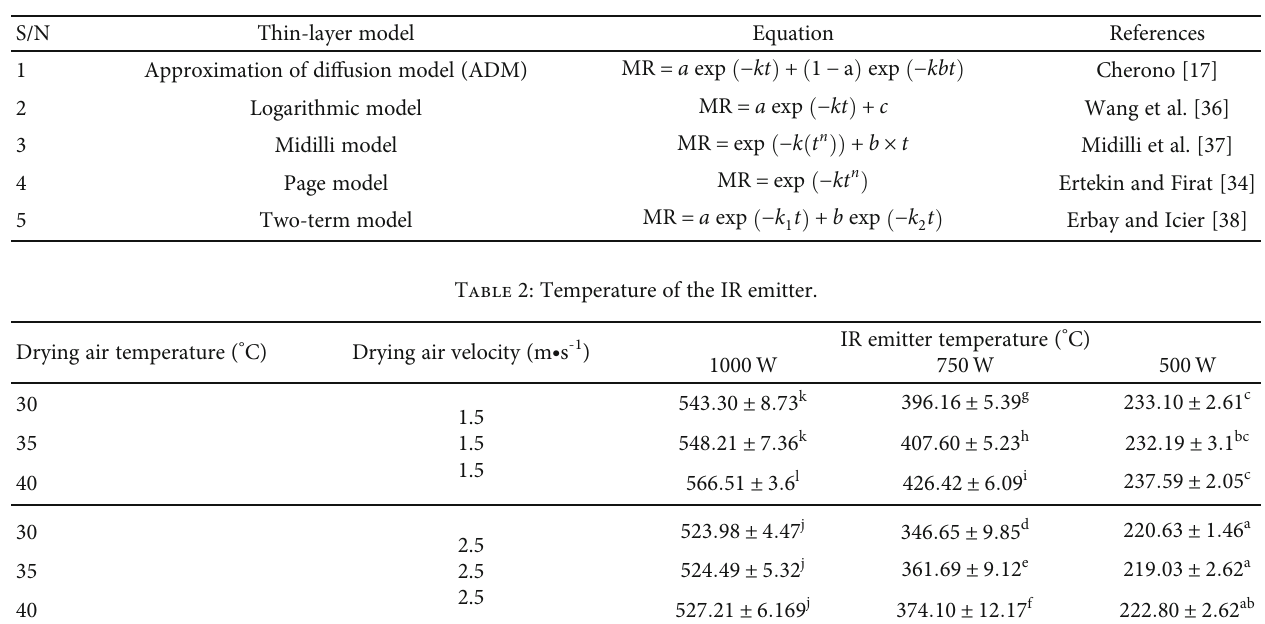
Table 1: Thin-layer drying models.